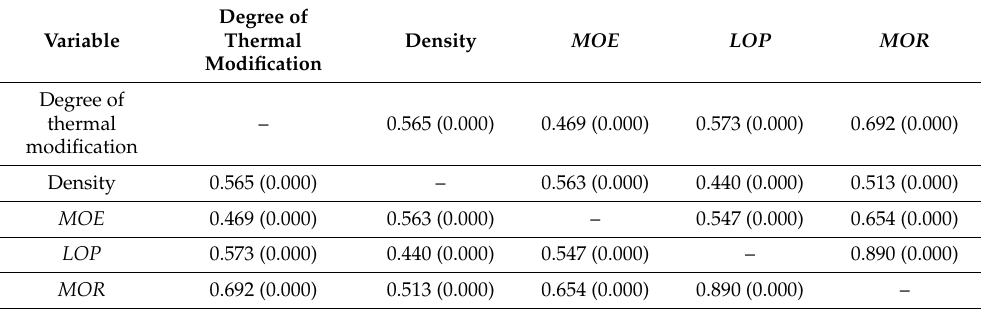
Table 2. Absolute correlations and their p -values for static